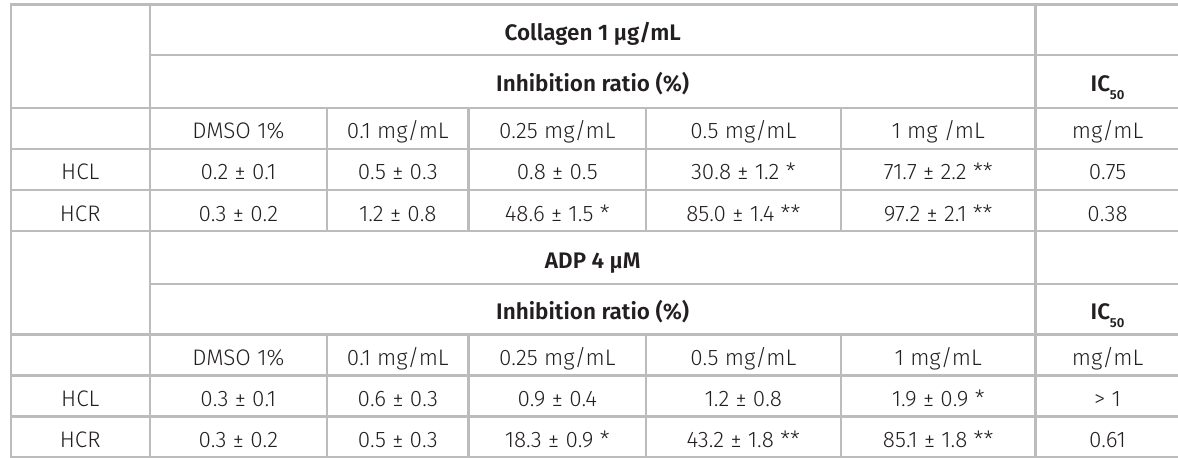
Table II. Percent inhibition of platelet aggregation of HCL and HCR